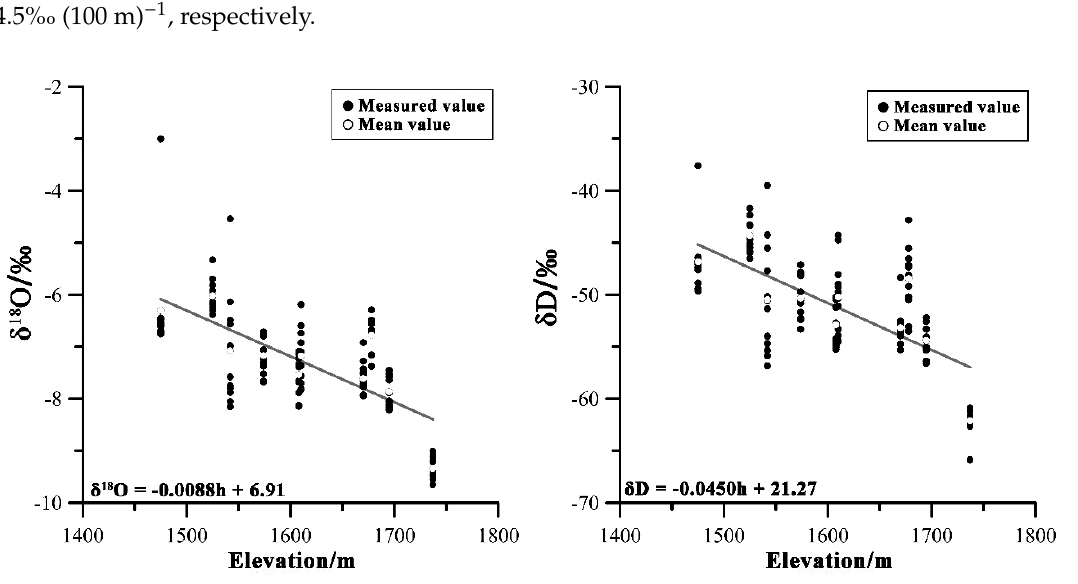
Figure 3. Variation in groundwater isotope values ( δ 18 O and δ 2 H) with elevation.